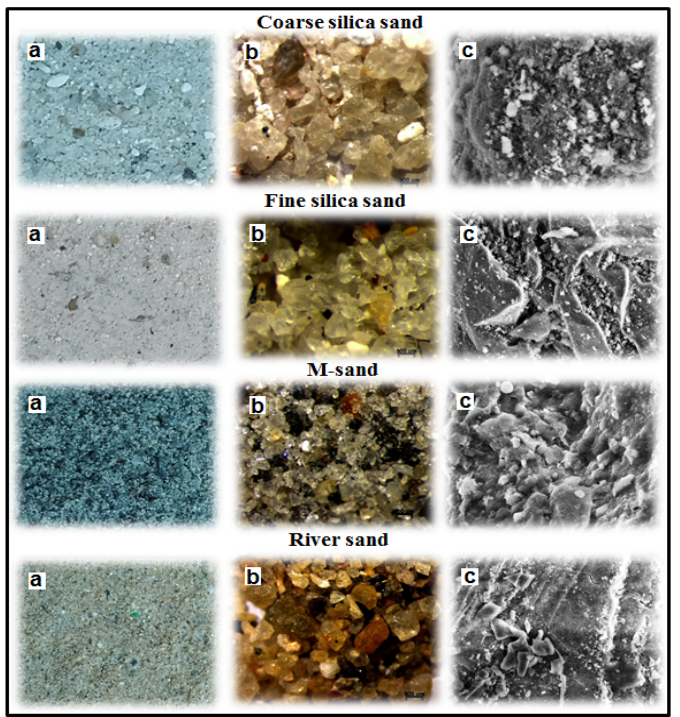
Figure 6. Image of sand samples ( a ) normal, ( b ) microscopic, and ( c ) SEM.